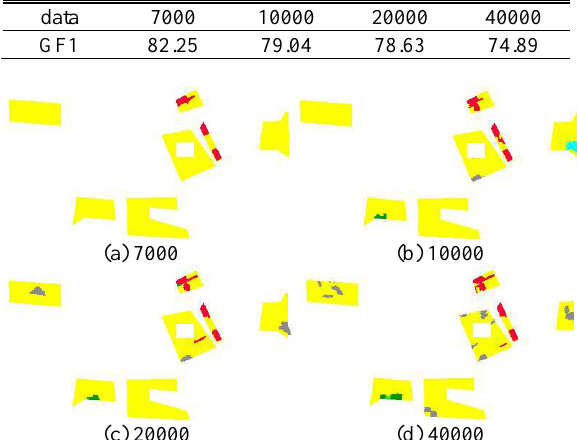
Fig.10 Segmentation result of different scales on small GF1 data. Table II Classification accuracy of different segmentation scales.